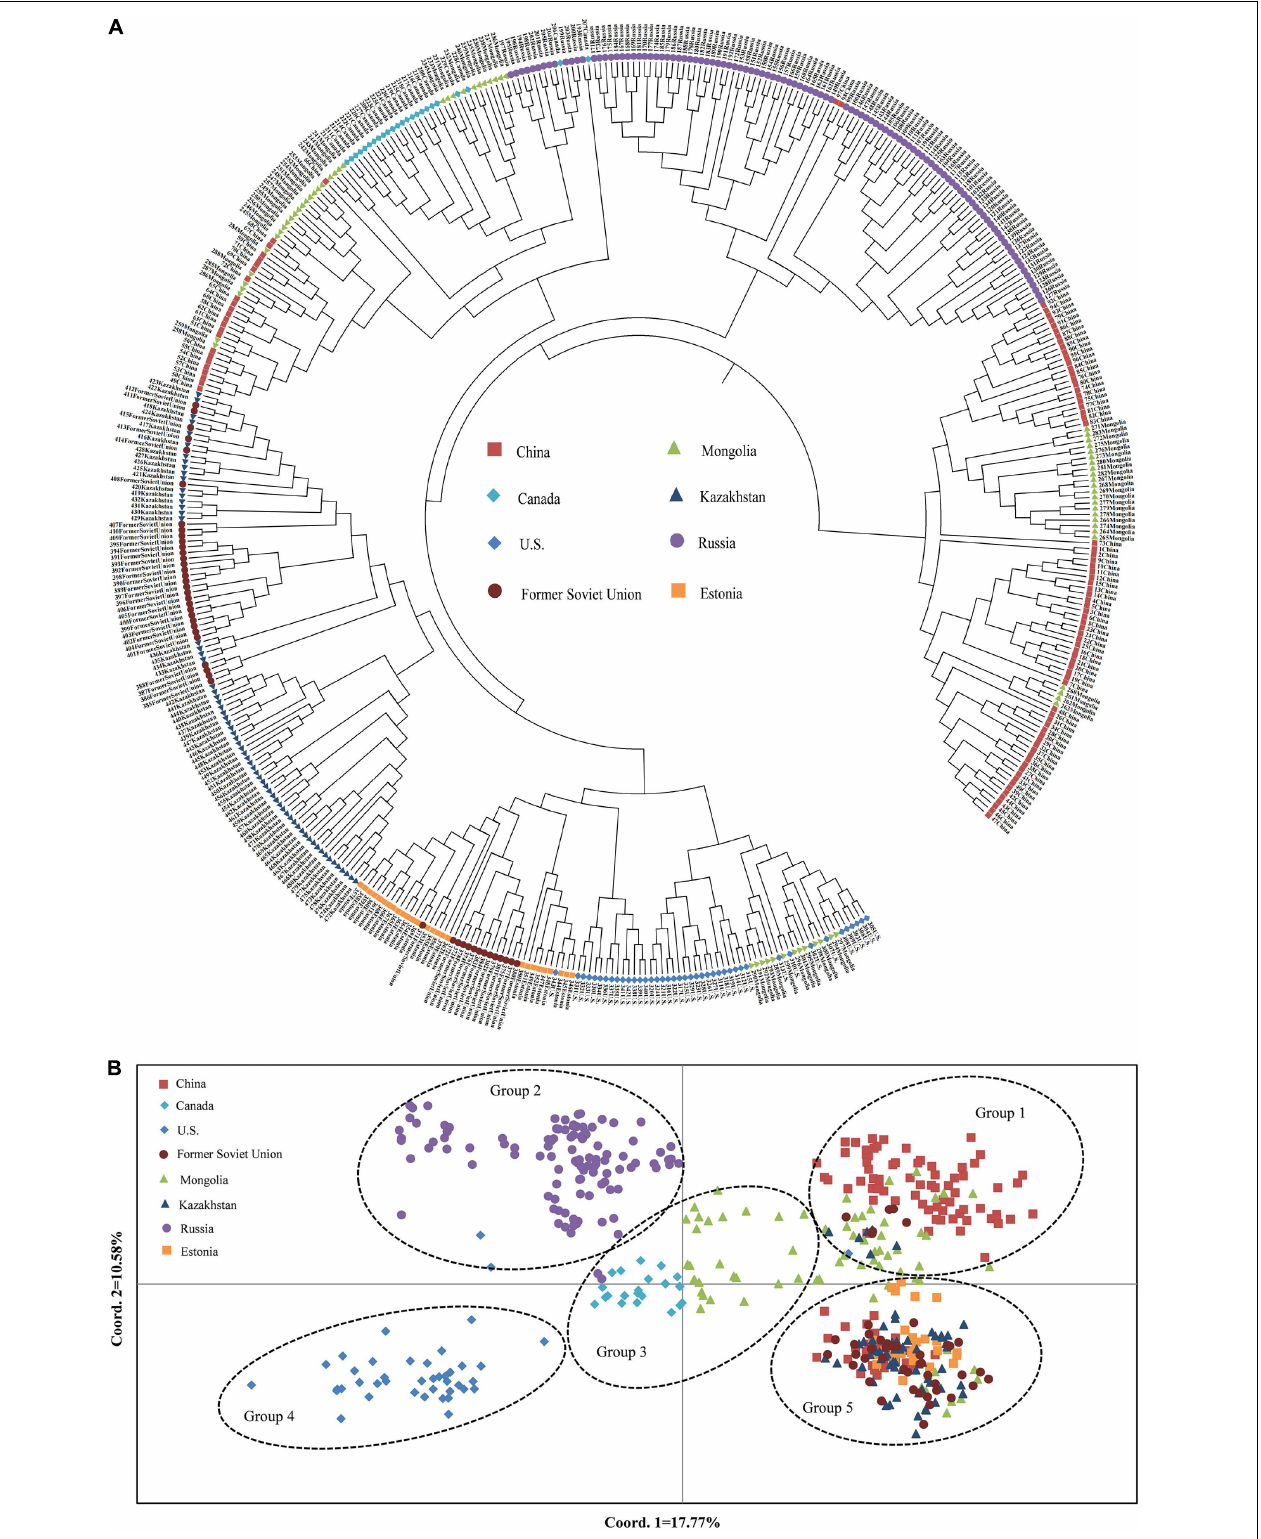
FIGURE 6 | The UPGMA (A) and PCoA (B) analysis among 480 Psathyrostachys juncea.